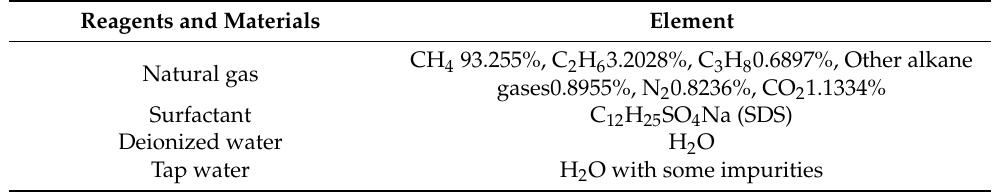
Table 3. Experiment Reagents and Materials List.